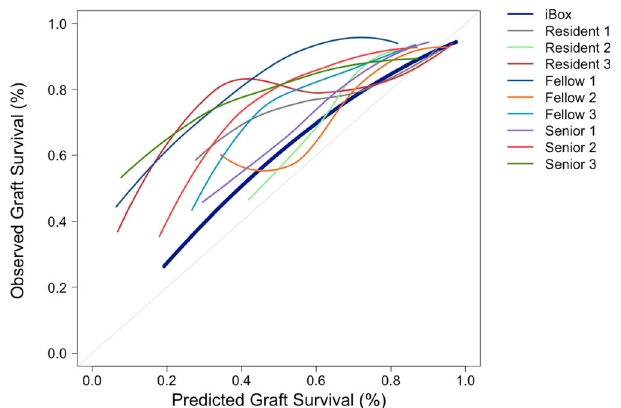
Fig. 3 Smoothed calibration curve comparing the observed graft survival and the predicted graft survival of each physicians ’ and the arti fi cial intelligence-based prediction system. n = 400 patients, nine transplant physicians and the iBox system. Calibration plots at seven years post risk evaluation for the four hundred patients. Vertical axis is observed proportion of grafts surviving at seven years. Average predicted probability (predicted survival; x -axis) was plotted against Kaplan – Meier estimate (observed overall survival; y -axis). Gray line represents perfectly calibrated model. Except the dark blue line which represents the smoothed iBox predictions, each plot represents Physicians ’ predictions. The intercept and slope were 0.135 and 0.87 for the iBox system, 0.48 and 0.46 for Resident #1, 0.00 and 1.14 for Resident #2, 0.31 and 0.78 for Resident #3, 0.47 and 0.51 for Fellow #1, 0.48 and 0.66 for Fellow #2, 0.32 and 0.65 for Fellow #3, 0.22 and 0.83 for Senior #1, 0.33 and 0.79 for Senior #2, 0.55 and 0.44 for Senior